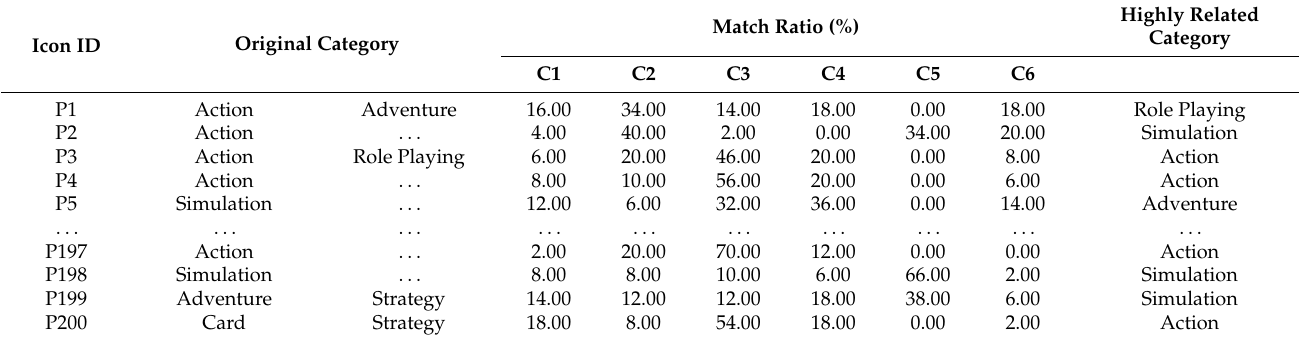
Table 3. Match ratio between 6 categories and 200 icon samples after the classification task.